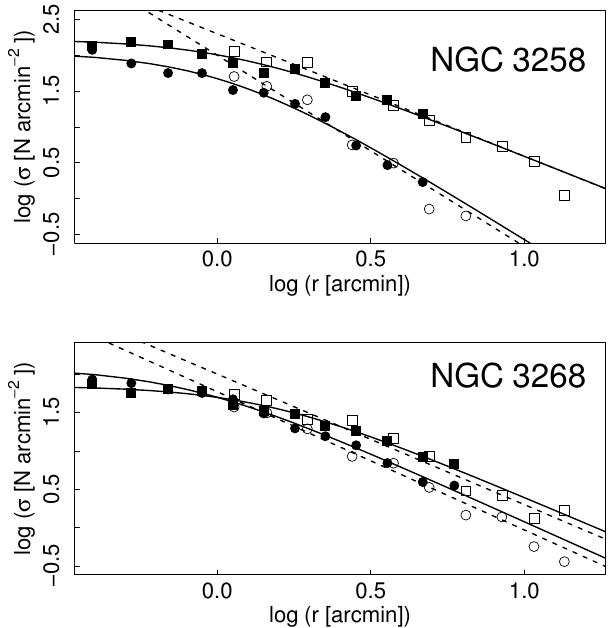
Figure 2. Background and completeness corrected radial profiles from FORS1 data for blue (filled squares) and red (filled circles) globular clusters (GCs). The open symbols shows the MOSAIC data, properly scaled. Solid curves represent the Hubble modified profile fitted to FORS1 data, and dashed ones the power-laws fitted to MOSAIC